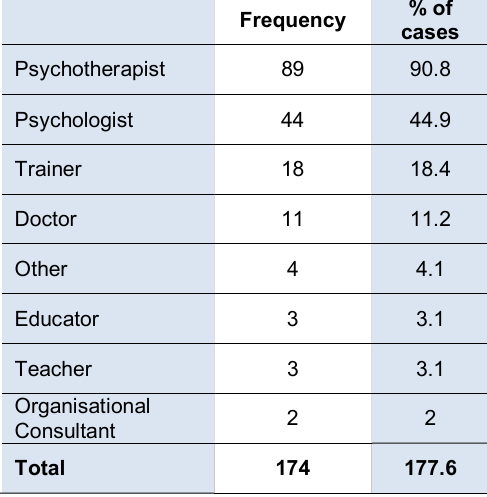
Table 2 - How the participants define themselves from the professional point of view. n = 98